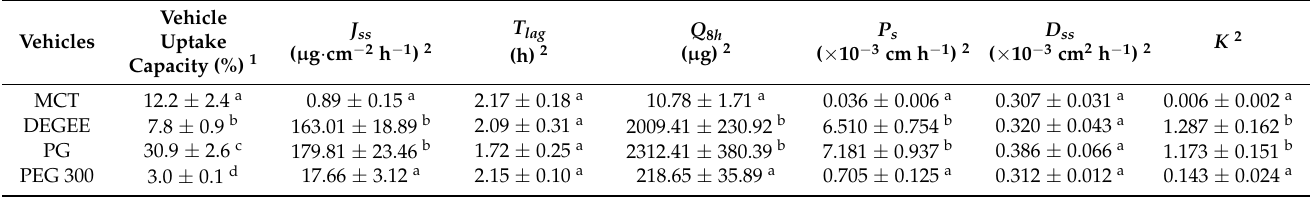
Table 2. Vehicle uptake capacity of mucosa and ex vivo permeation parameters of CBD with neat vehicles.